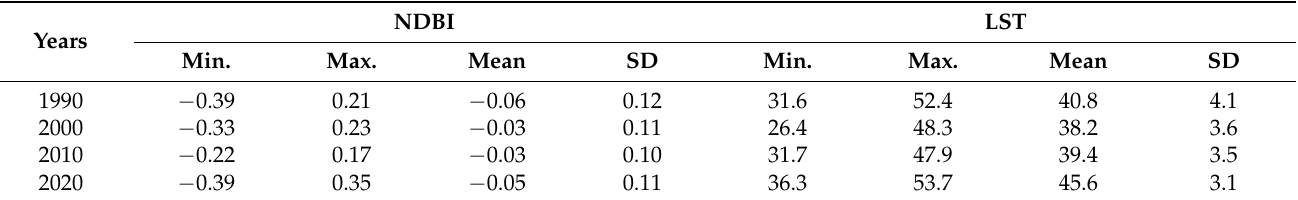
Table 5. Descriptive statistical information for NDBI and LST over the period of 1990 to 2020.